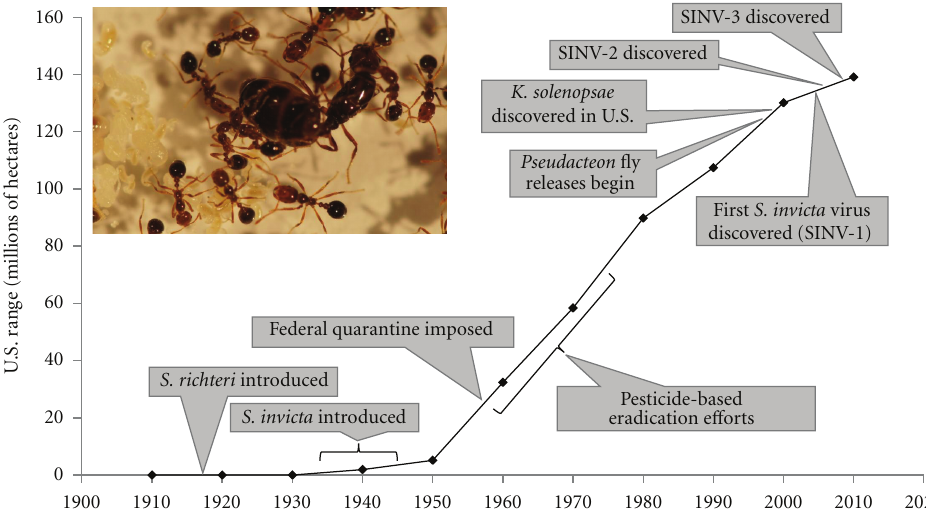
Figure 1: Seminal events during the invasion of Solenopsis invicta and S. richteri in relation to their USA quarantined range. Since the introduction of S. invicta and S. richteri into the USA, e ff orts to contain and eradicate the ants have been attempted [2, 4]. The USA federal government emplaced a quarantine in May 1958 to limit the rate of range expansion of the ants. This quarantine is still enforced by the Animal and Plant Health Inspection Service (APHIS) today and prohibits movement of soil-containing products (e.g., sod, nursery stock, sand, etc.) or soil-moving equipment from a quarantined to a non-quarantined area unless first treated in an APHIS-specified manner to kill fire ants. The range values correspond to areas quarantined and do not relate changing population densities in the USA. Rather, the graph illustrates the expanding geographic range of these ants. Eradication e ff orts were attempted from 1957 through 1978 using several organochlorine insecticides (heptachlor, dieldrin, and mirex). Research e ff orts to discover, develop, and release pathogens and parasites as control agents in the USA resulted in identification and/or release of a microsporidian pathogen ( Kneallhazia solenopsae ) [18], viruses [24– 26], and Pseudacteon parasites [28]. Inset: S. invicta queen surrounded by workers and brood. Quarantine data were provided by APHIS [3] and the figure was adapted from Lofgren